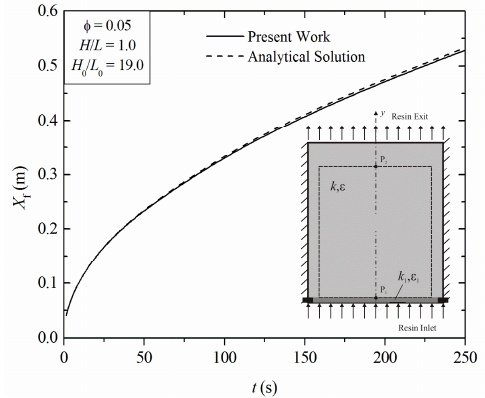
Figure 4. Comparison between the placement of resin flow as a function of time by analytical solution.